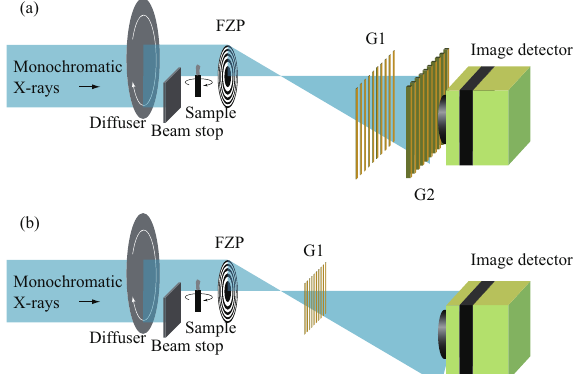
Figure 8. Configurations of X-ray phase microscopy by the combination of a Fresnel zone plate (FZP) and gratings: Approaches by ( a ) Talbot interferometry and ( b ) single phase